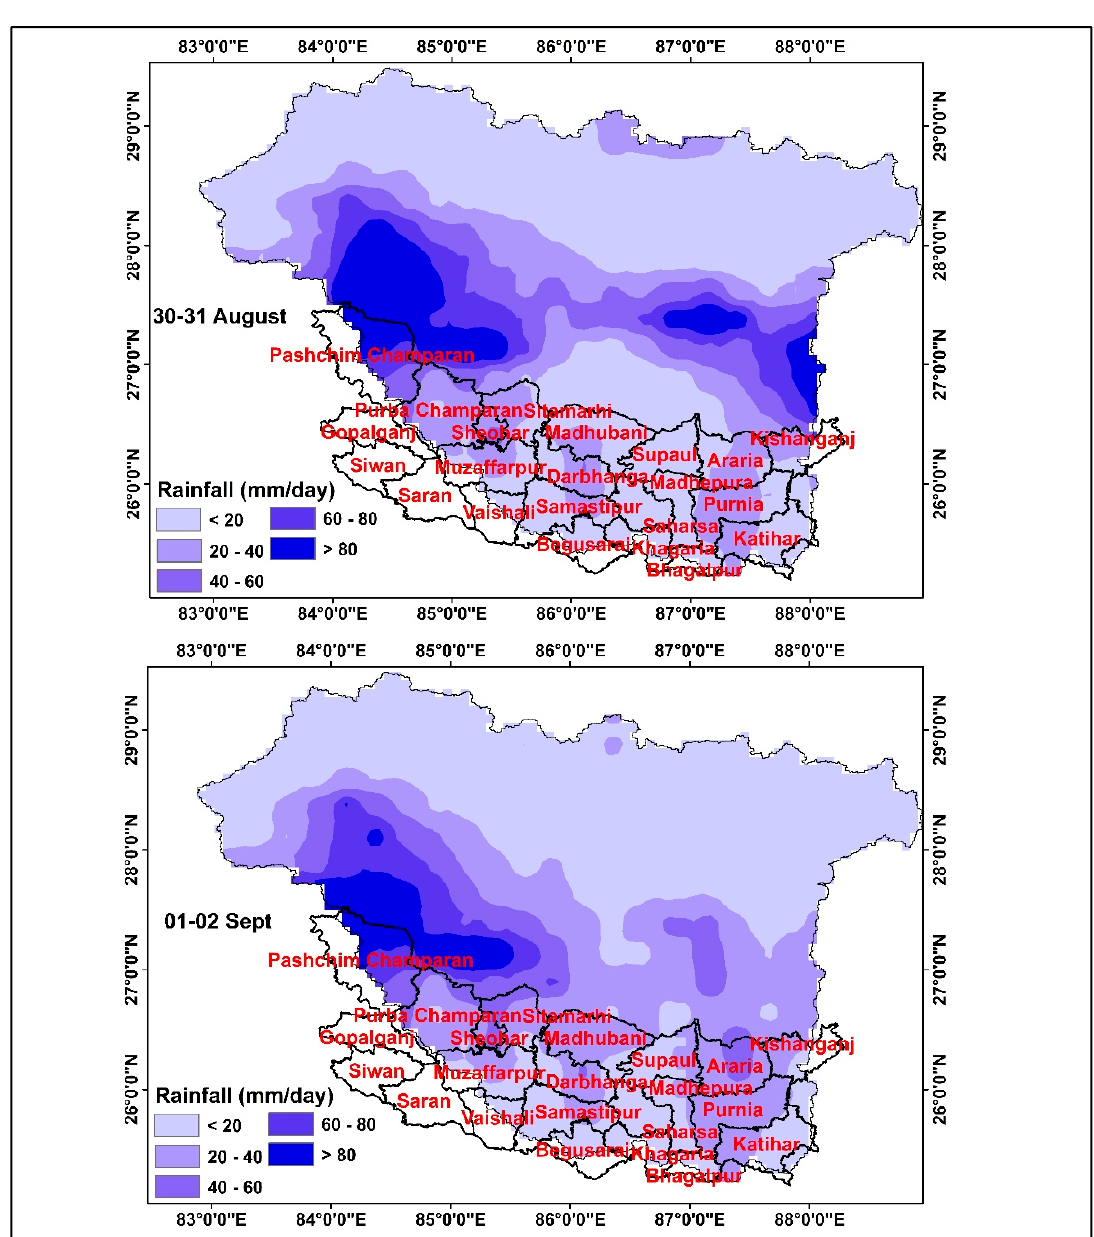
Figure A1. Rainfall variability over North Bihar during 30–31st August and 1–2nd September, 2017.